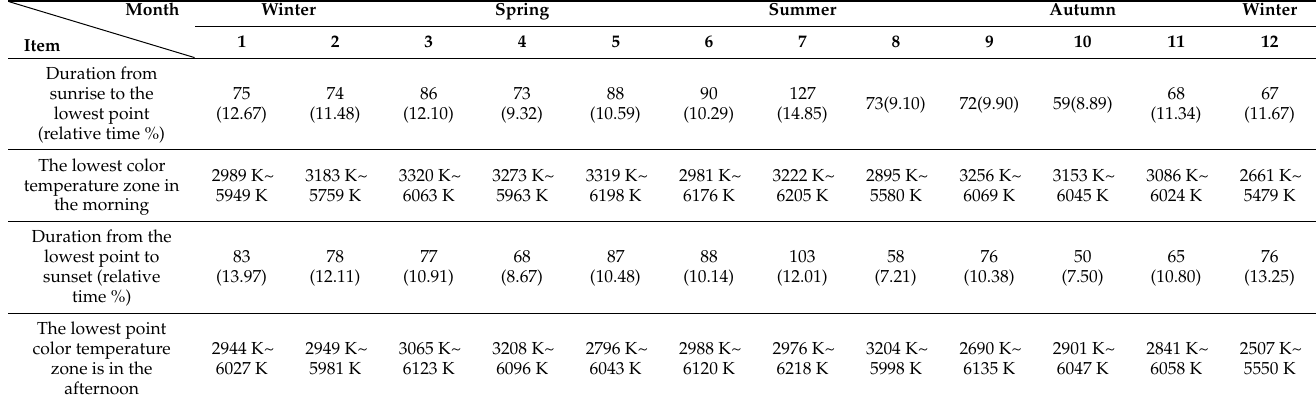
Table 3. Occurrence of the lowest monthly color